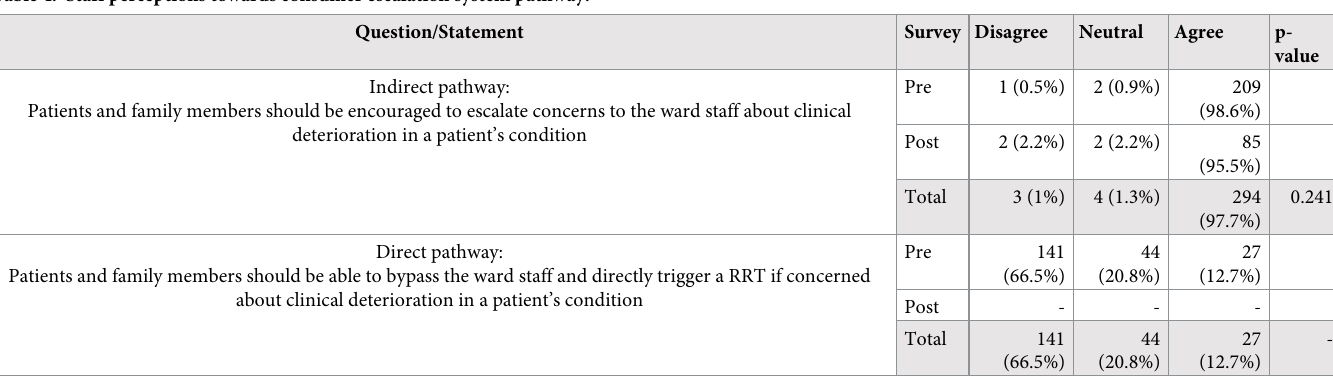
Table 4. Staff perceptions towards consumer escalation system